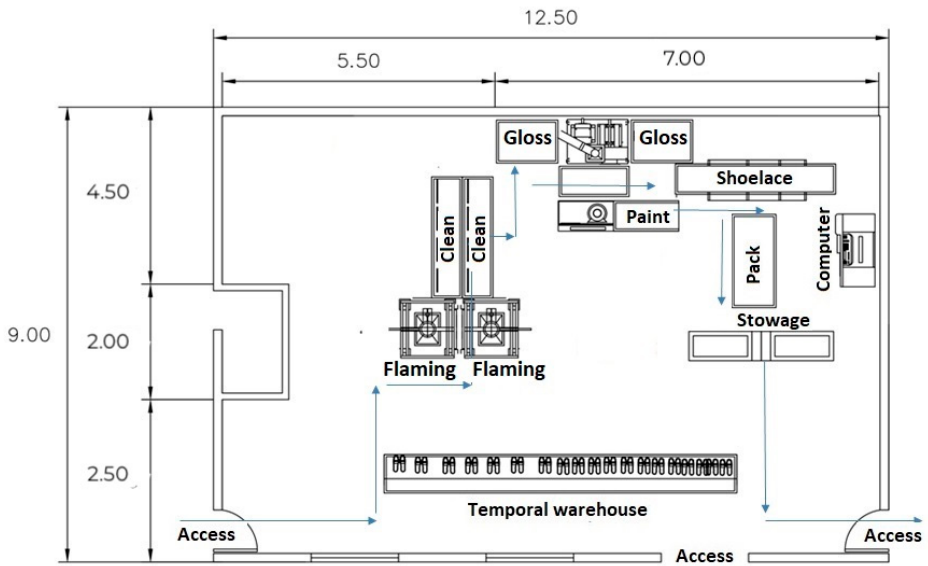
Figure 7. Flow of the proposal process, merger of both lines, elaborated by the author.